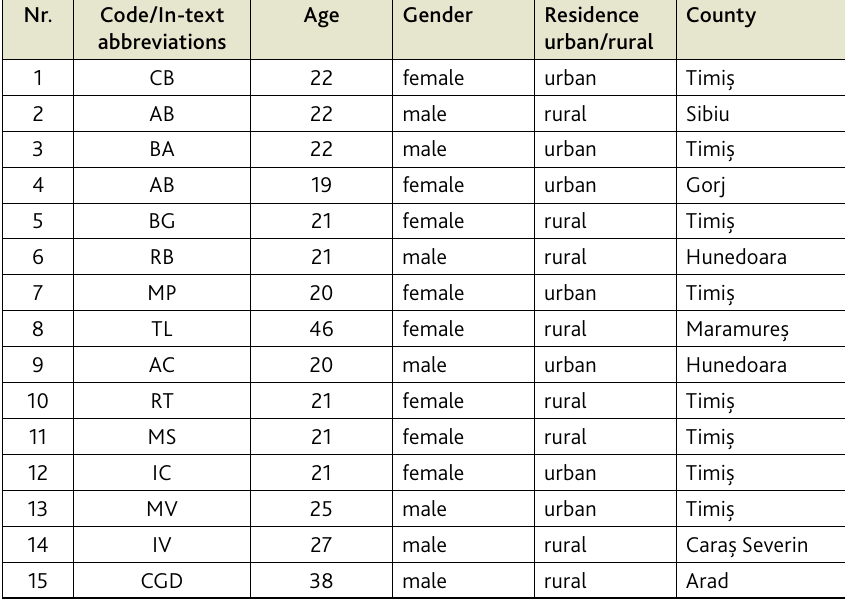
Table 1. Socio-demographic characteristics of respondents.